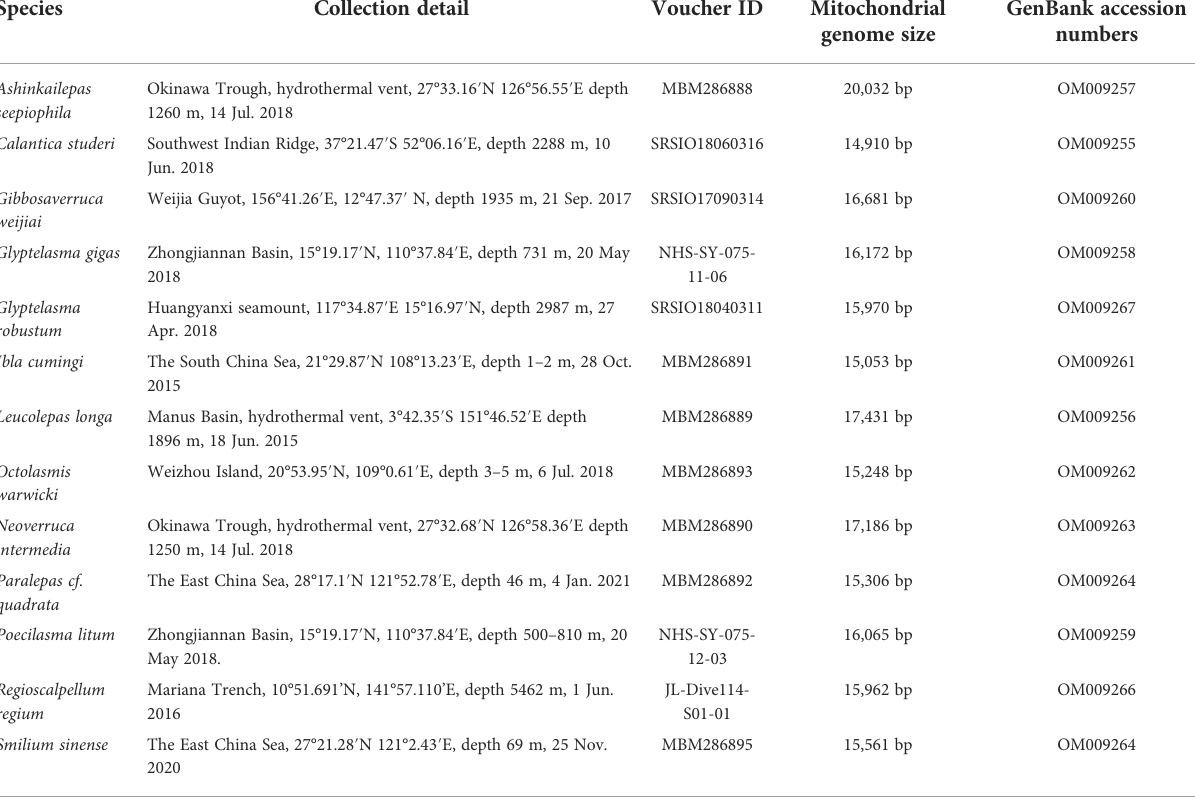
TABLE 1 Collection and mitogenome information for the newly sequenced specimens used in this